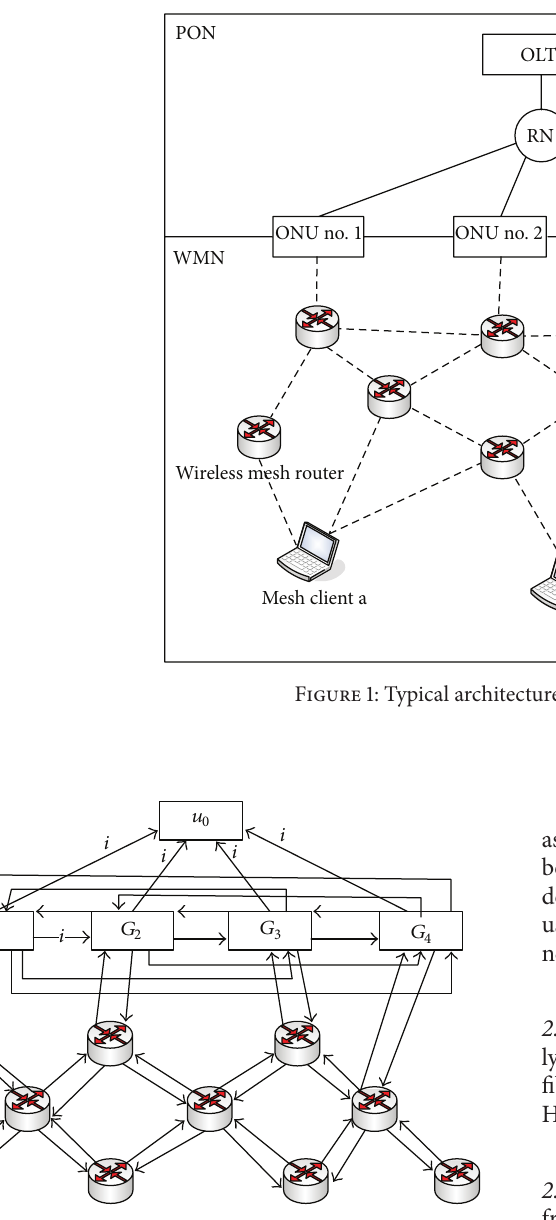
Figure 2: Architecture of Fi-Wi Network with multiple ONUs, where all ONUs (i.e., 𝑁 𝐺 ) are connected with each other with the wired link of infinite capacity ( 𝑖 ) and also connected to OLT ( 𝑢 0 ) with the wired link of infinite capacity ( 𝑖